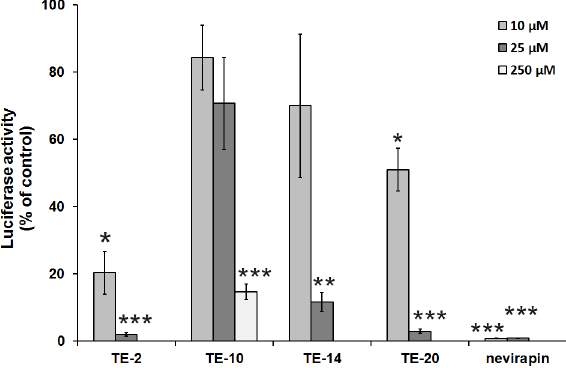
Fig 2. Inhibition of HIV infection of TZM-bl cell cultures. Monolayer TZM-bl cells were infected with HIV-1 in 0.2 ml DMEM medium in the presence of 10 μ M or 25 μ M test compound (in case of TE-10 also 250 μ M) or an inhibitor control (nevirapin). Additionally, one well was mock infected (no virus, negative control). After 40 h, the cells were assayed for expression of luciferase activity. The value for the vehicle control was set to 100% in each individual experiment and the negative control was set to 0%. All other values were normalised against these reference values. The data are means of three independent experiments; the error bars represent the SEM. P-values are indicated if significant ( * : p < 0.05; ** : p < 0.01; *** : p <